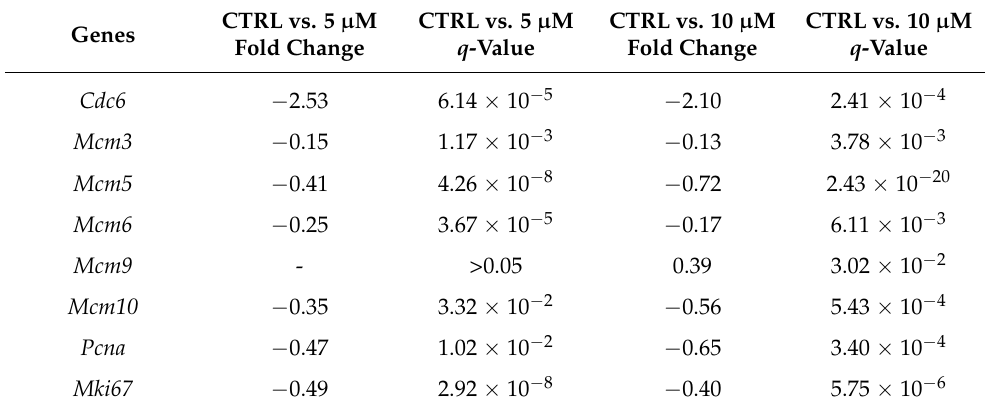
Table 4. DEGs of MCM and the genes associated with the proliferation.